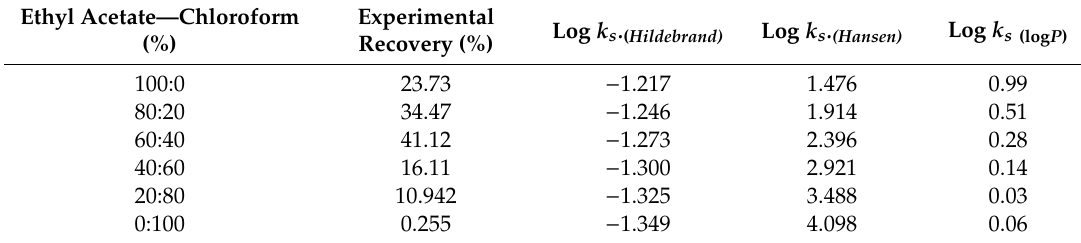
Table 4. Experimental recovery of rosmarinic acid and calculated retention factor ( k s ) for the fractions. Ethyl Acetate—Chloroform (%)